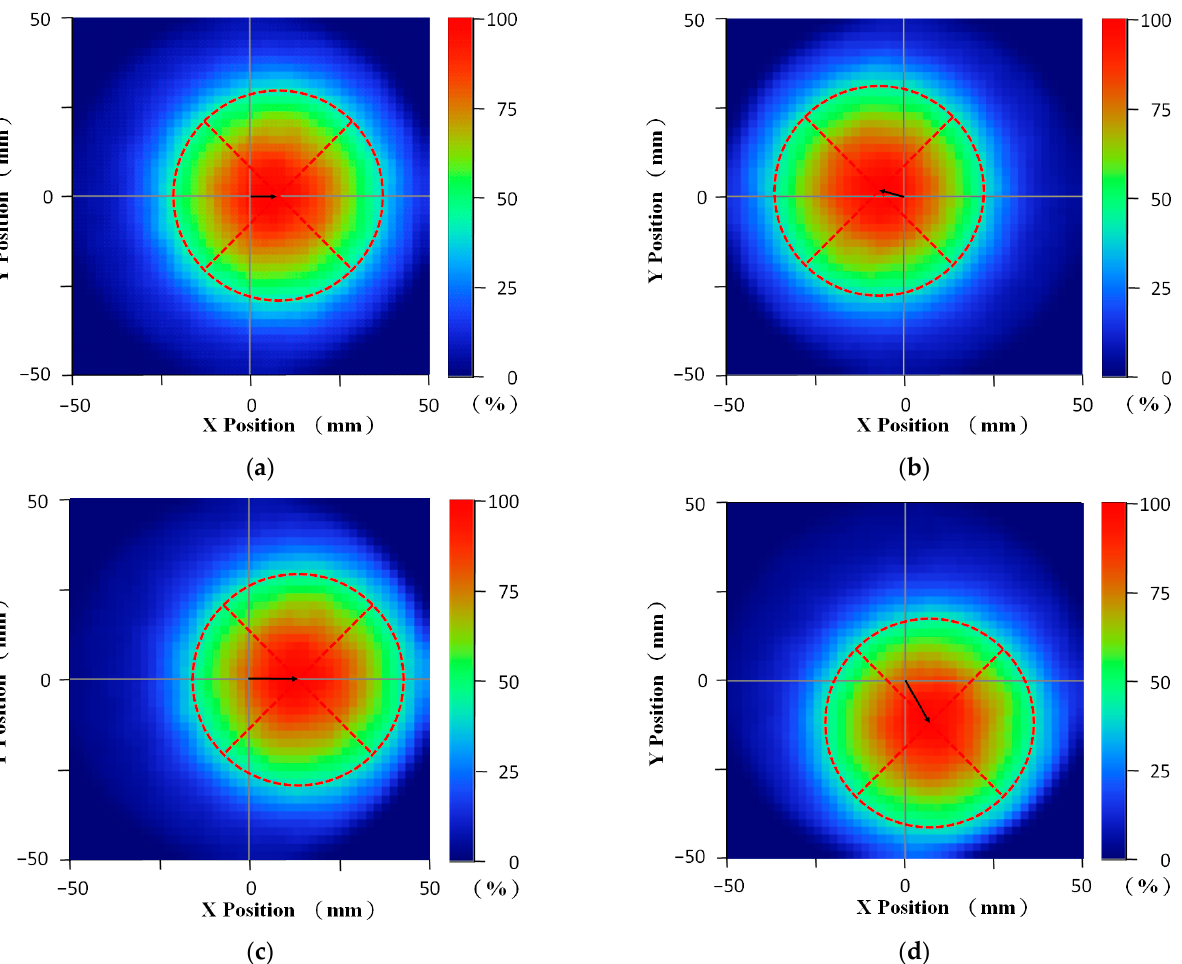
Figure 2. Four irradiance distributions of the LPL units with specified deviations on the exposure working plane: ( a ) inclination angle 1° and azimuth angle 0°, ( b ) inclination angle 1° and azimuth angle 165°, ( c ) inclination angle 2° and azimuth angle 0°, and ( d ) inclination angle 2° and azimuth angle 300°.